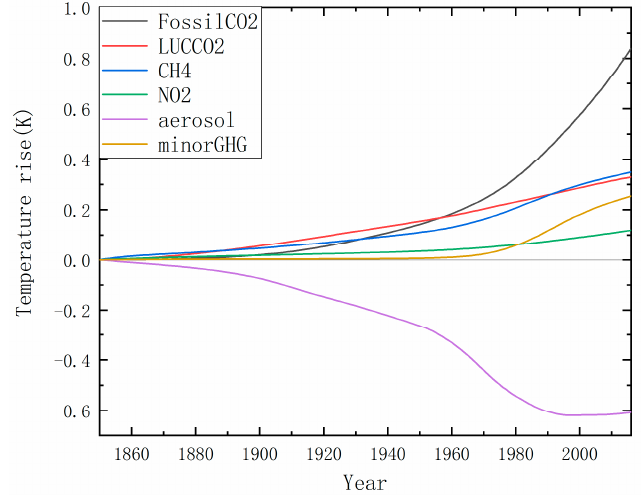
Figure 7. Different GHGs contributions to temperature rise. Figure 7. Di ff erent GHGs contributions to temperature